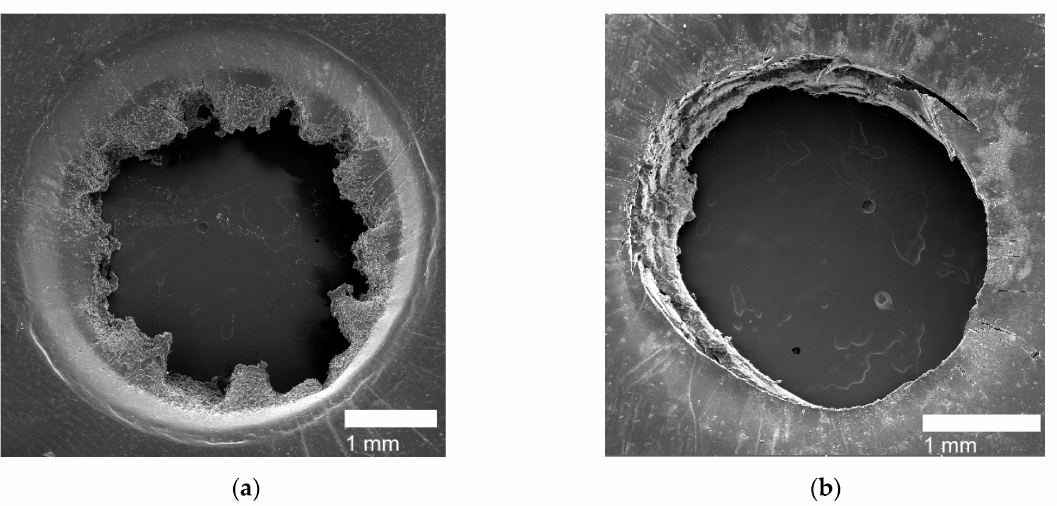
Figure 11. SEM image ( a ) shows the high impact response of the PE sample and SEM image